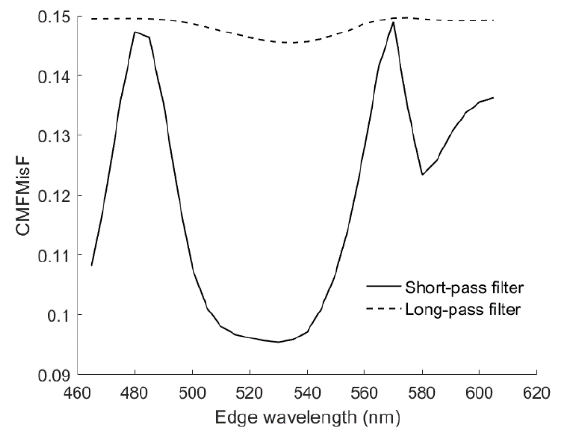
Figure 16. CMF mismatch factor CMFMisF versus the edge wavelength of the optical filter.